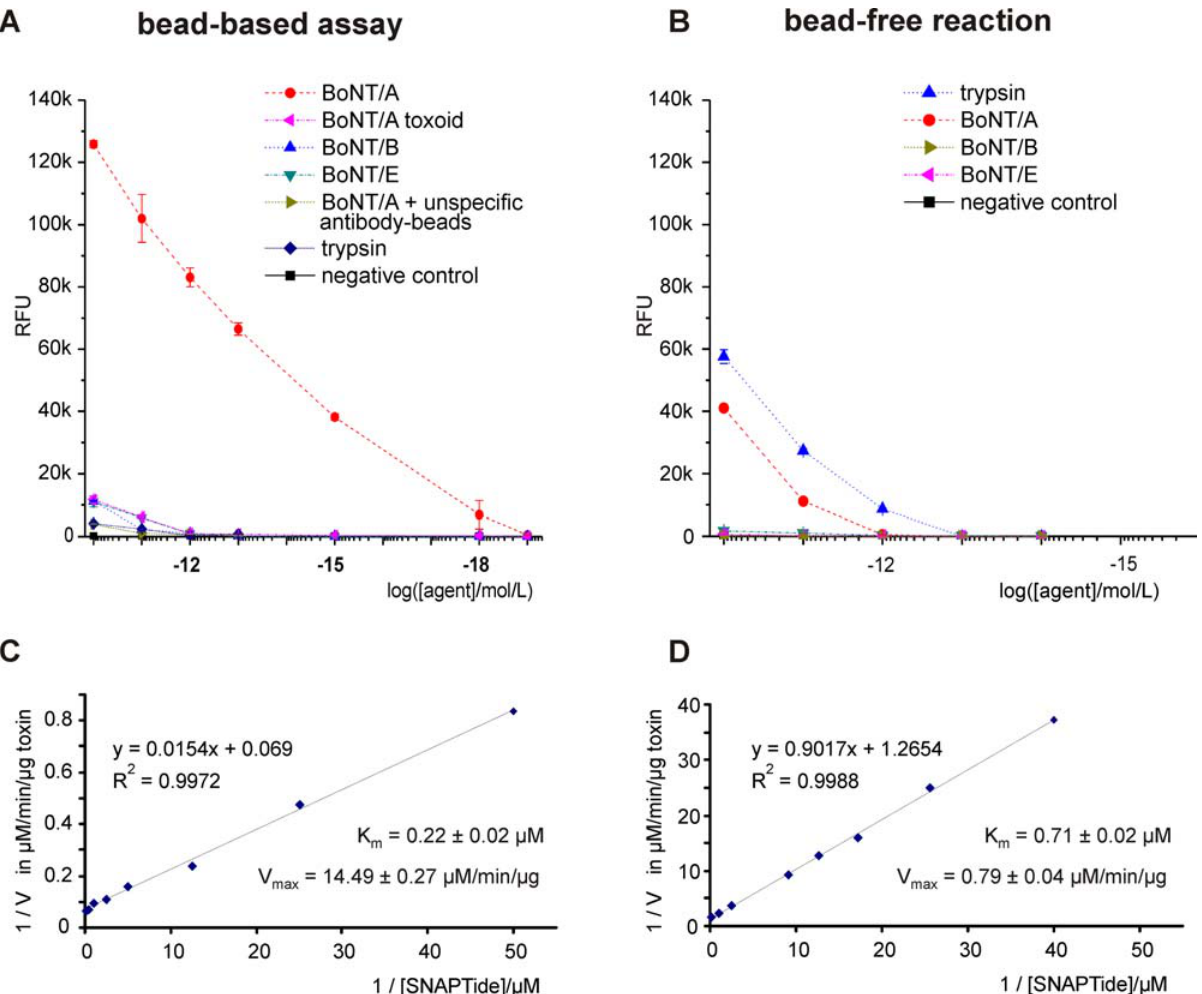
Figure 4. BoNT/A ALISSA versus bead-free SNAPtide cleavage. Comparison between (A, C) the bead-based assay and (B, D) the bead-free reaction in 10% FBS. (C, D) Lineweaver-Burk (double reciprocal) plots of the BoNT/A reaction rate as a function of the substrate (SNAPtide) concentration. Note different y-axis scales. The solid lines represent linear regression fits.